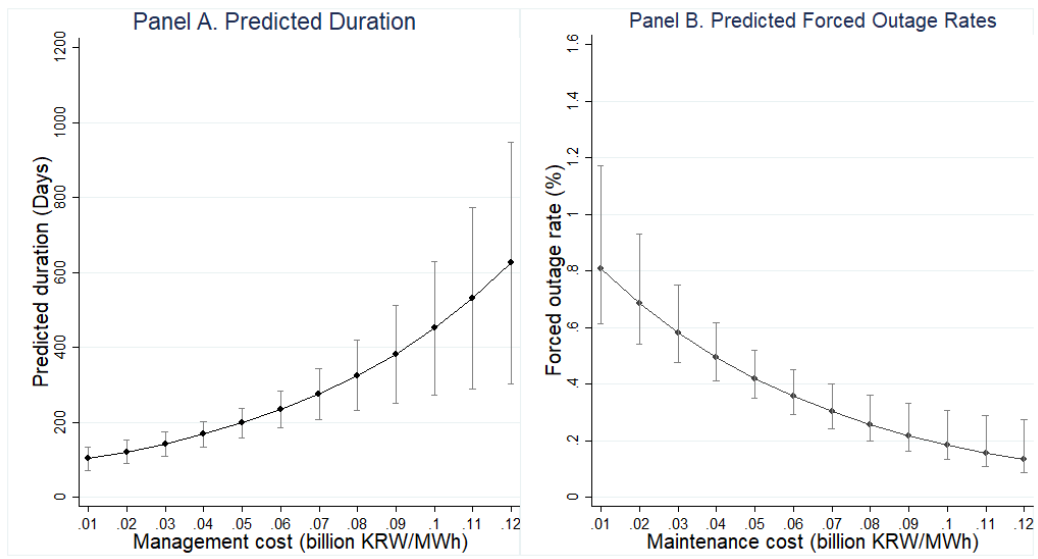
Figure 4. Predicted duration (days) and forced outage rates (%). Note: Generated based on Exponential AFT model (Table 2); vertical bars indicate 95% confidence intervals calculated using delta